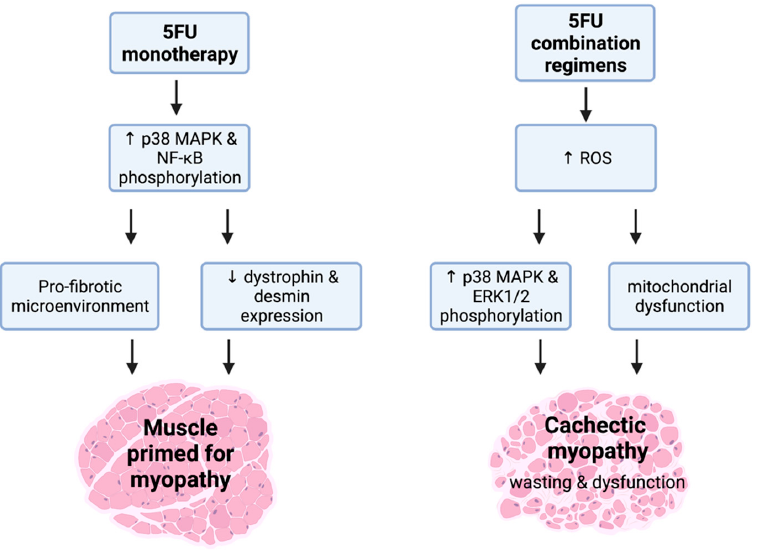
Figure 3. (5FU)-related cachectic myopathy. 5FU monotherapy promotes the phosphorylation of atrophic regulators, p38 mitogen activated protein kinase (MAPK), and nuclear factor kappa-light-chain-enhancer of activated B cells (NF- κ B). These mechanistic targets are likely to be stimulated via signalling modulators including reactive oxygen species (ROS). 5FU does induce a pro-fibrotic skeletal muscle microenvironment and reduces the expression of the key cytoskeletal proteins, desmin and dystrophin, which suggests that 5FU primes muscle for cachectic myopathy. Interestingly, when additional chemotoxic insult to skeletal muscle occurs alongside 5FU such as in 5FU combination regimens, the induction of cachectic myopathy is observed. This is underscored by increased ROS production that stimulates the phosphorylation of p38 MAPK and ERK1/2 alongside mitochondrial dysfunction, leading to skeletal muscle wasting and dysfunction. Created with biorender.com (accessed on 6 July